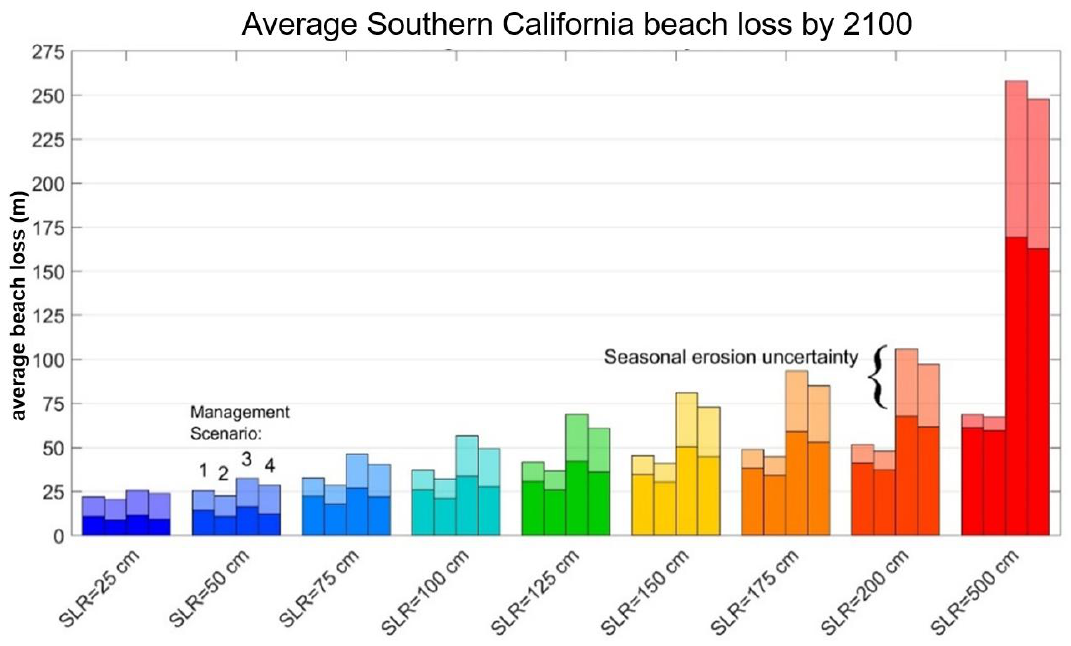
Figure 3. Average beach loss in Southern California derived from the shoreline change model under different management and sea-level rise (SLR) scenarios (see O’Neill et al. and Vitousek et al. [16,30] for model details). The four management scenarios are (1) “hold-the-line” (hard structure to limit erosion) with no continued nourishment; (2) “hold-the-line” with continued nourishment; (3) no structures/limit on erosion and no continued nourishment; and (4) no structures/limit on erosion and continued nourishment. Figure modified from Vitousek et al. [30].